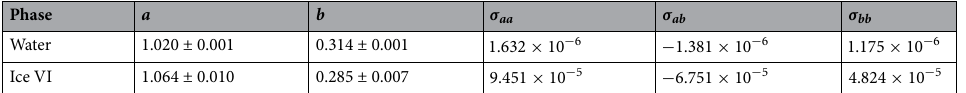
Table 3. Fitting parameters and covariance matrix elements of the modified Gladstone–Dale model for water (0.05–1.29 GPa) and ice VI (1.17–2.21 GPa).